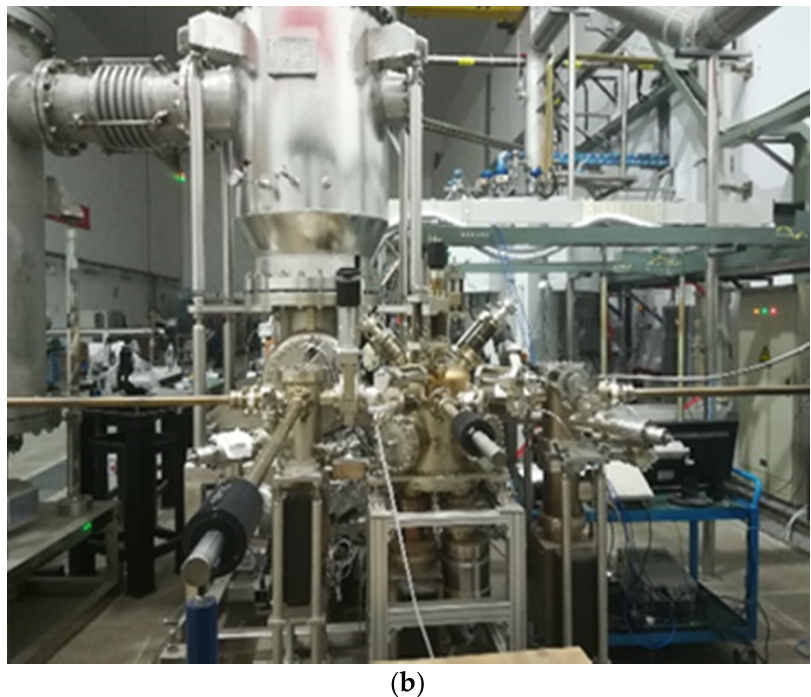
Figure 9. The schematic ( a ) and picture ( b ) of the GaAs photocathode deposition system at CAEP. At IHEP, a GaAs photocathode was used as the electron source in the 500 kV DC gun. During the beam experiment, the QE of GaAs photocathode was about 5% (@532 nm) and a 5 mA average current CW beam was derived. Now the DC gun at IHEP is used as the high energy photon source (HEPS) test bench, which is used to test the SRF cavities and cryo-modules for XFEL and the proposing circular electron-positron collider